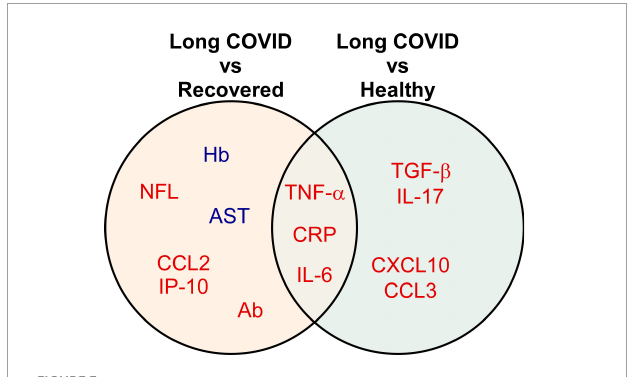
FIGURE3 Biomarkers significantly associated with different comparison groups. The Venn diagram presents the 13 biomarkers that were reported by two or more eligible studies. Red indicates up-regulated, while blue refers to down-regulated biomarkers. A detailed list of abbreviations in Figure 3 can be found in Supplementary Table 2 .